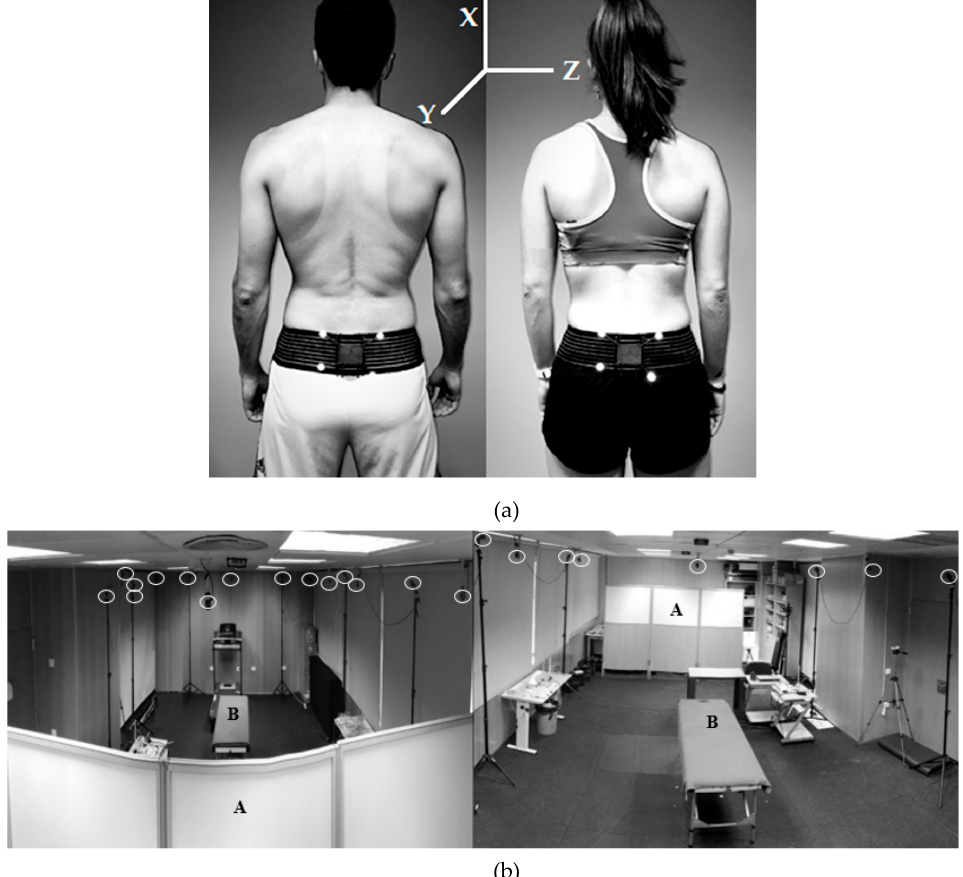
Figure 3. ( a ) Placement of inertial device and spherical markers on the sacrum in men and women. ( b ). Back and front view of the experimental set-up, which included folding screens (A), testing area (B), and 16 optoelectronic cameras (white circles) .